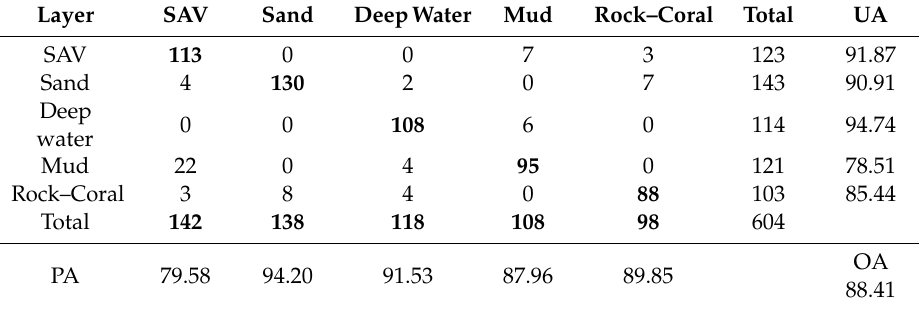
Table A3. Landsat-8 confusion matrix table (2018).